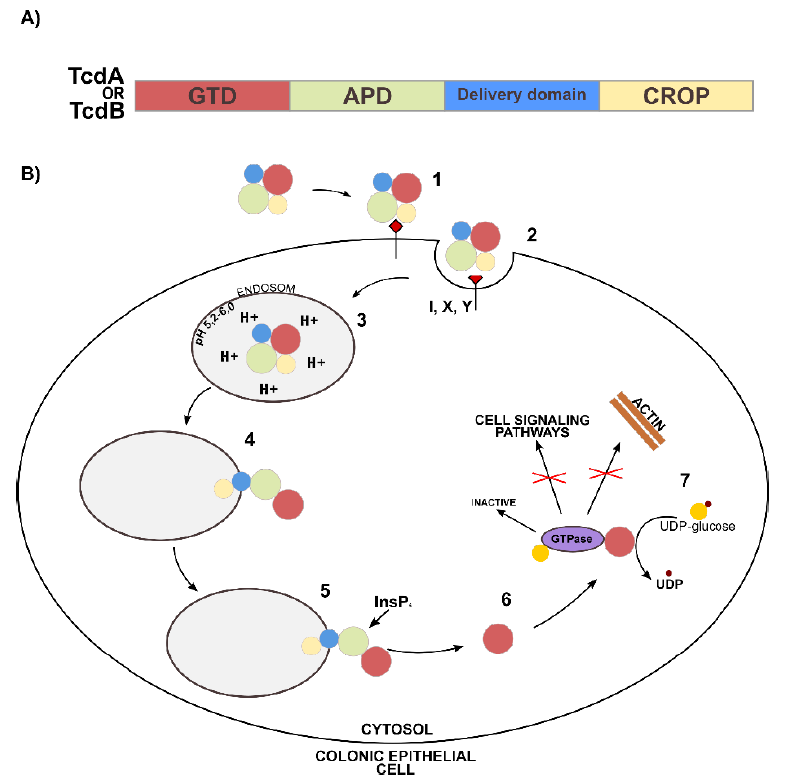
Figure 3. Mechanism of action of TcdA and TcdB. ( A ) Four functional domains of TcdA and TcdB: glycosyltransferase domain (GTD), autoprocessing domain (APD), translocation domain, repeat oligopeptide domain (CROP,) ( B ) Multistage mechanism of cell intoxication by TcdA and TcdB [87].